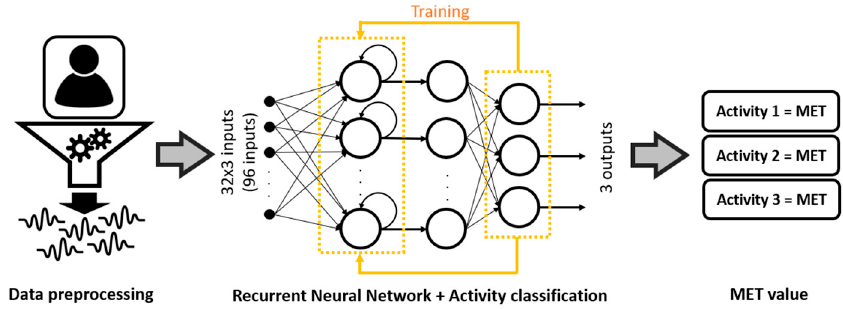
Figure 2. General methodology for estimating an on-line MET value with an RNN.